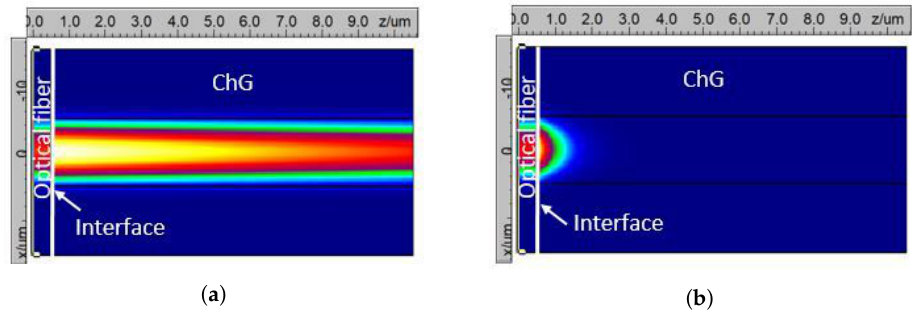
Figure 2. Ge 40 Se 60 -capped fiber device: Power distribution at the fiber:ChG interface for ( a ) amor- phous phase and ( b ) crystalline